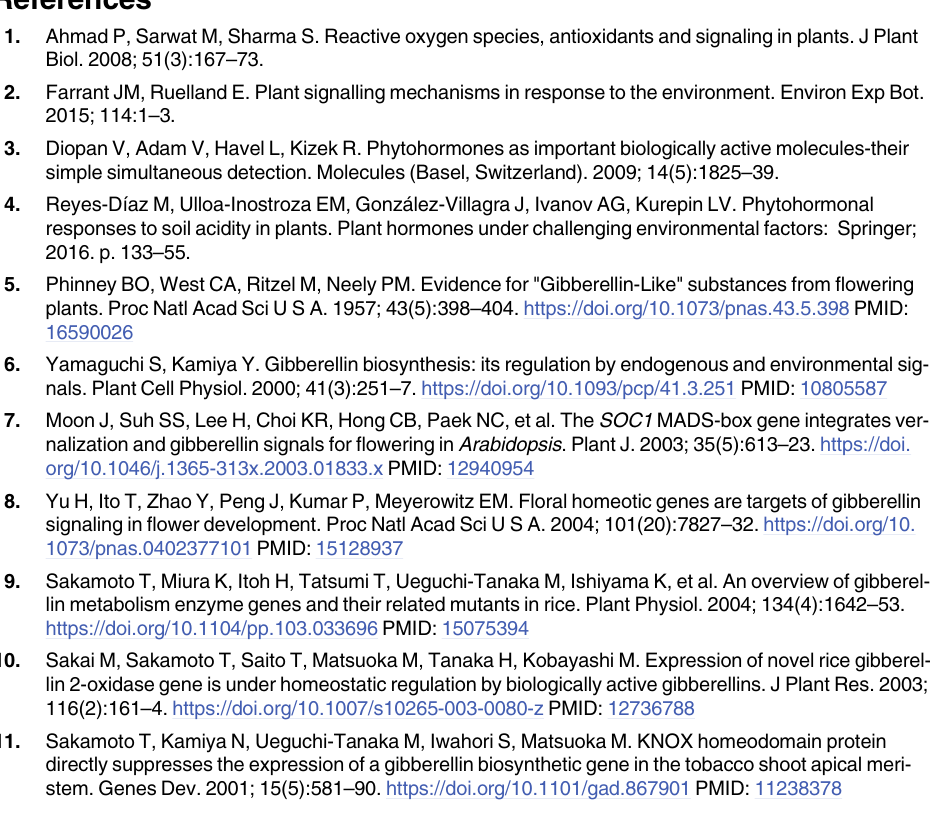
S1 Table. Sequences of primers used in RT-qPCR